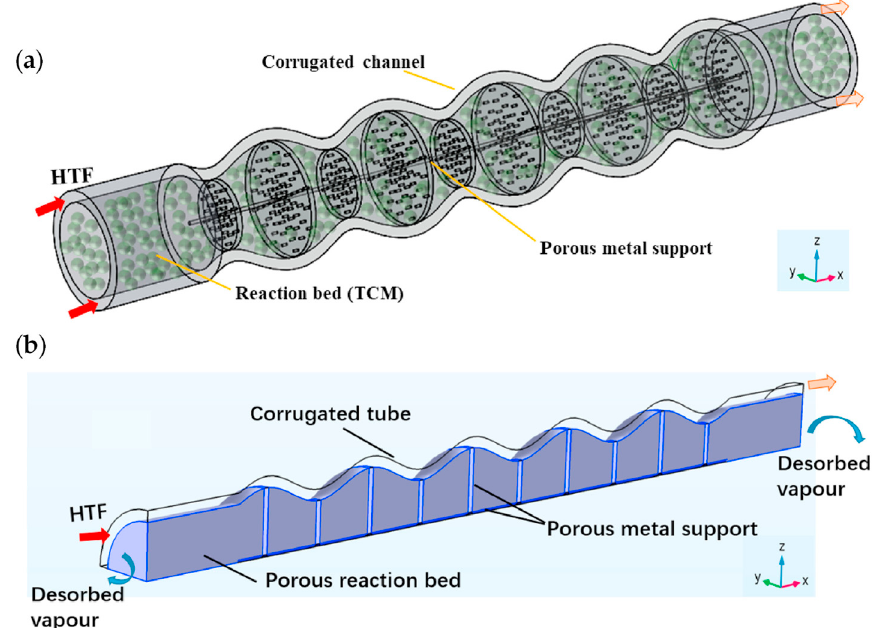
Figure 26. ( a ) Schematic diagram of the heat storage unit; ( b ) a quarter profile of the reaction unit [264]: Reprinted with permission from Ref. [264] Copyright © 2022 Elsevier Ltd. All rights